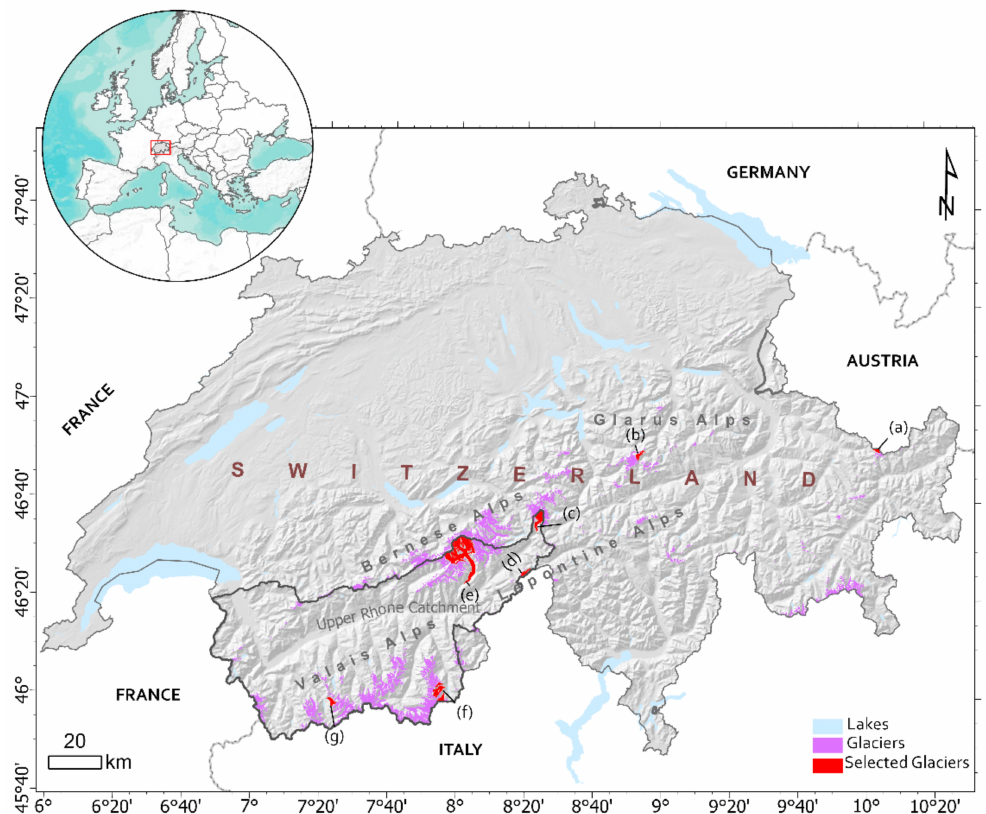
Figure 1. Overview maps of the research study area and the glaciers with mass balance measurements analyzed in this work (source: ESRI, USGS, NOAA, and DHM25/200). The map represents: ( a ) Silvretta ( b ) Clariden ( c ) Rhone ( d ) Gries ( e ) Grosser Altesch ( f ) Hohlaub, Allalin, Schwarzberg ( g )